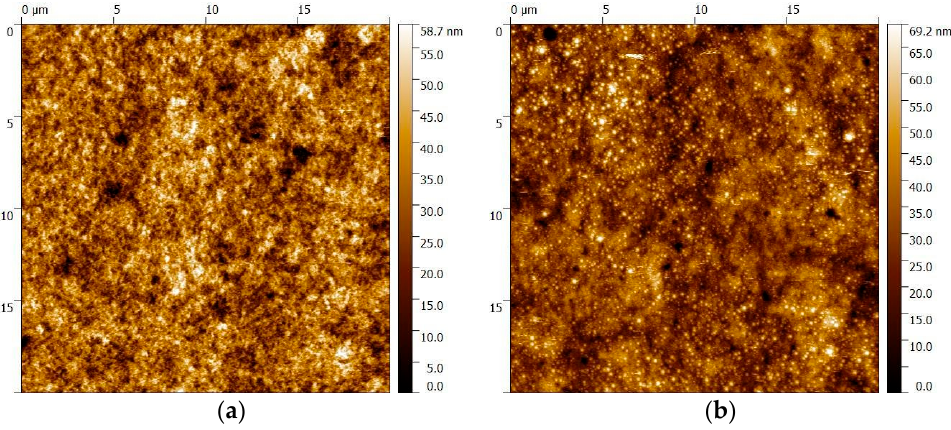
Figure 1. Atomic force microscopy (AFM) images of the electroplated substrates used for the determination of their roughness: ( a ) bronze; ( b ) copper. The roughness of the substrate must be very low in respect to the film thickness to ensure complete coverage.